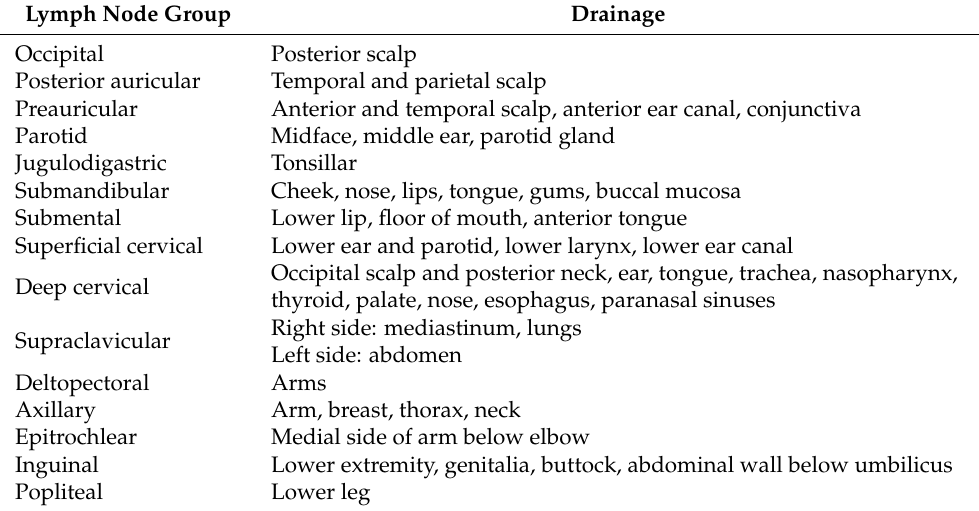
Table 2. Lymph nodes and their drainage